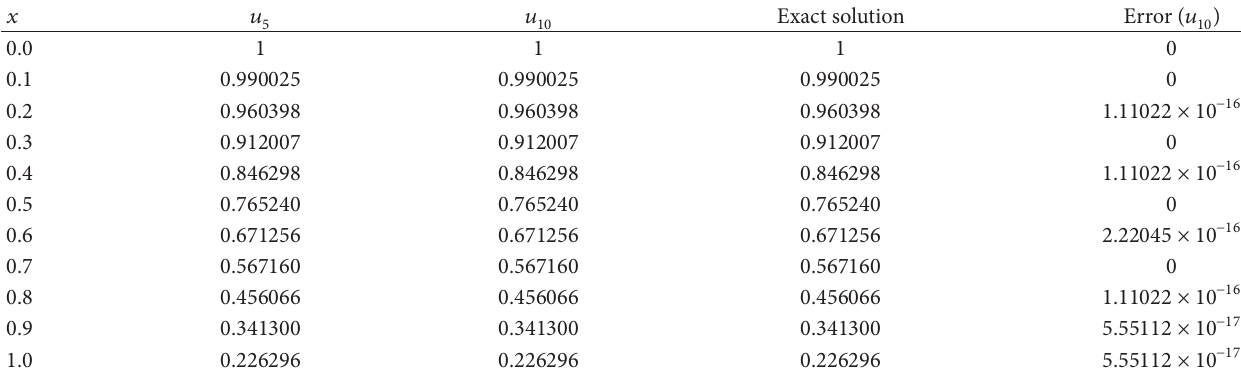
Table 2: Numerical result of Example